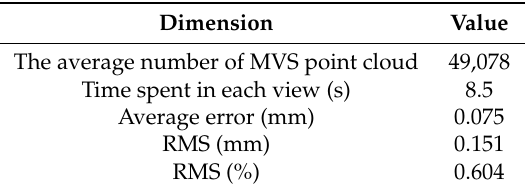
Table 6. The statistical results of the two